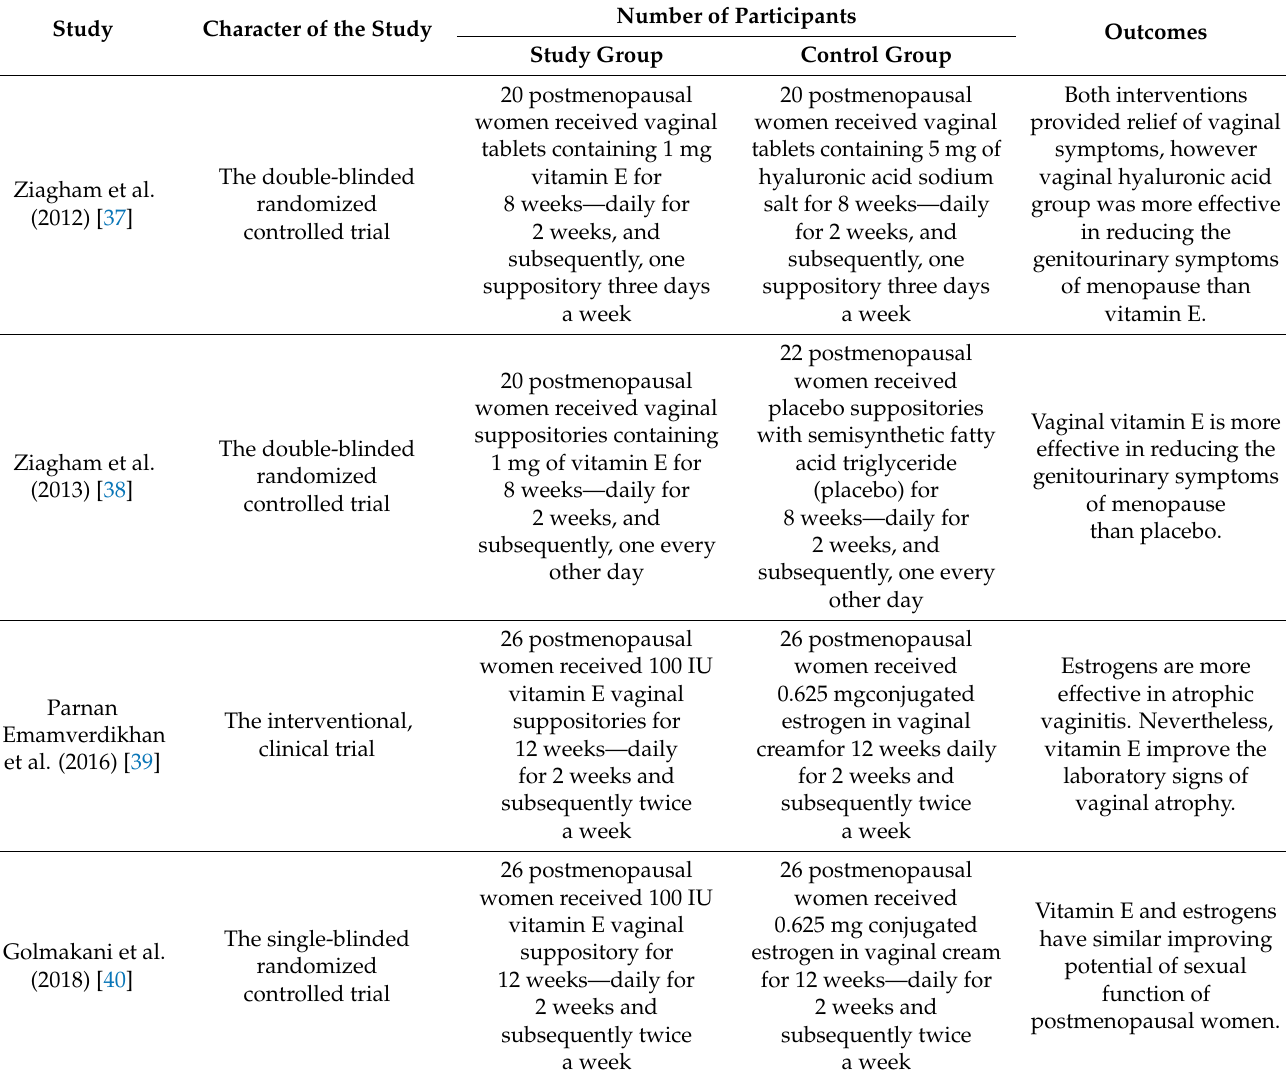
Table 2. Characteristics of included studies concerning atrophic